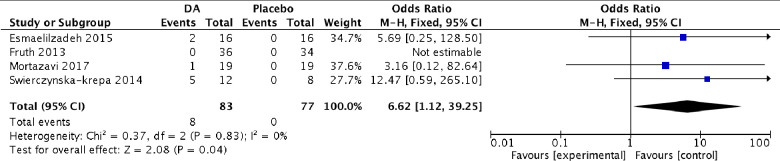
Forest plot of comparison.Aspirin desensitization vs placebo, outcome: nonfatal adverse events.